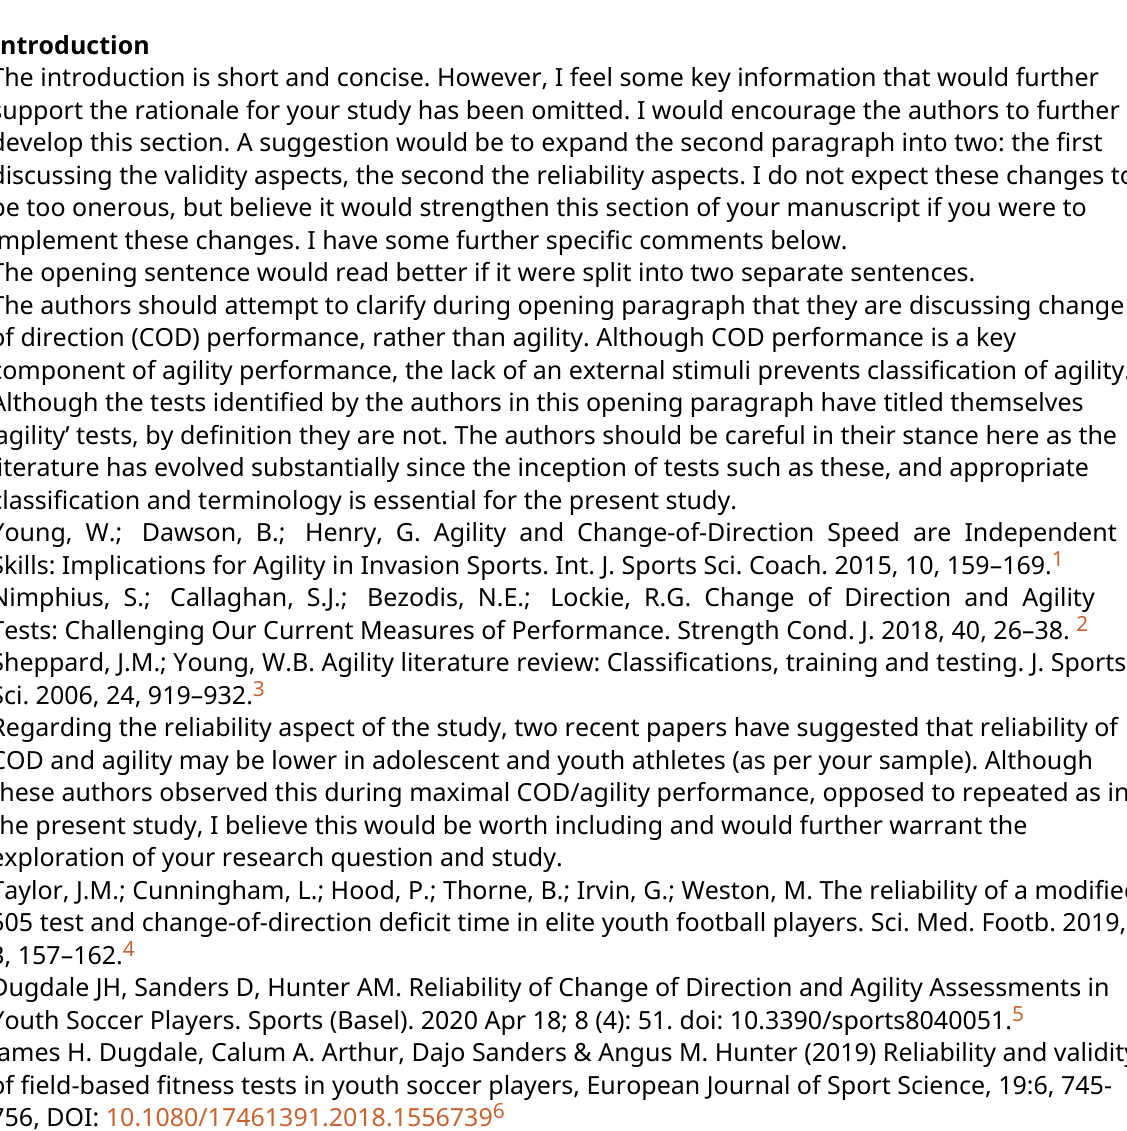
Figure 1: I am unsure how much this figure aids the interpretation of the study design. I personally do not feel the visual nature of this schematic clarifies the description of the trials